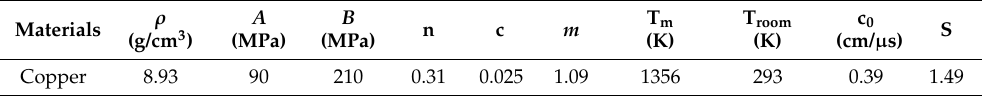
Table 1. Parameters of the liner material.